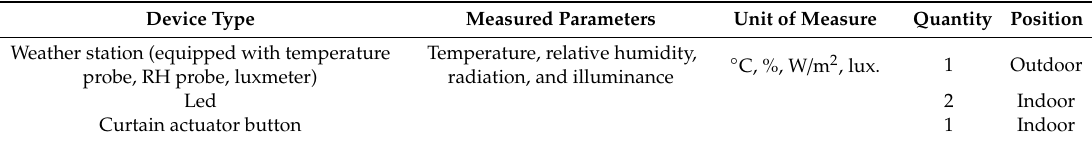
Table2. Accessoryand /